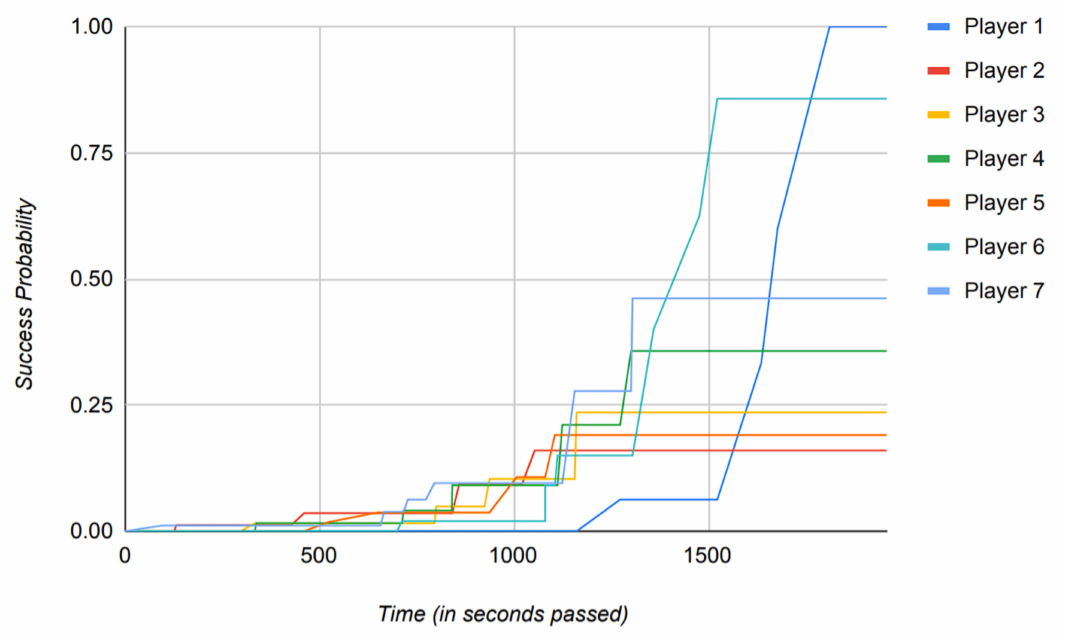
Figure 18. Success probabilities of top ~11% of players from a set of 82 players from a match of PUBG.